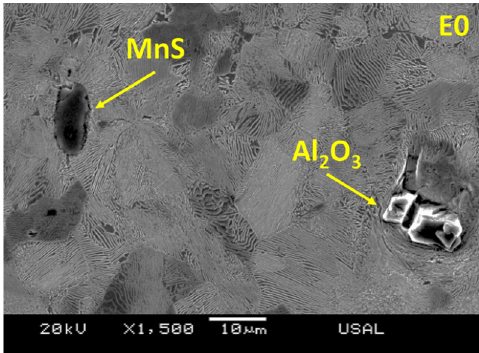
Figure 6. Second-phase particles in a hot rolled pearlitic steel.